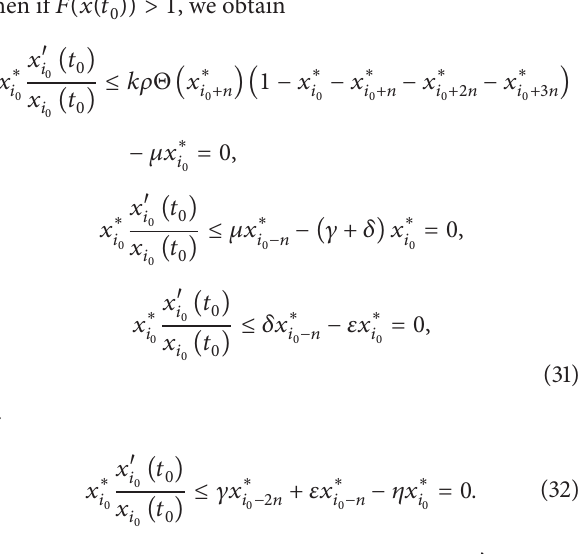
Figure 3: Global stability of infection-free solution.